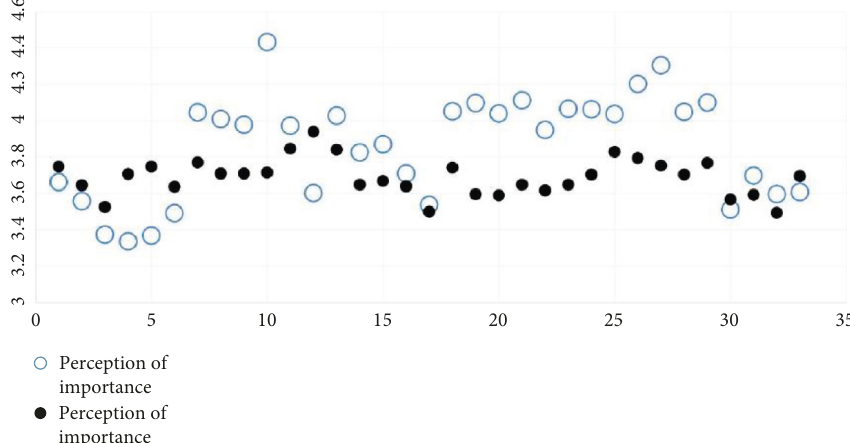
Figure 6: Perception of importance versus perception of given in Figure 8. Quadrant 1: there are 13 rural tourism public health service indicators located in this quadrant.